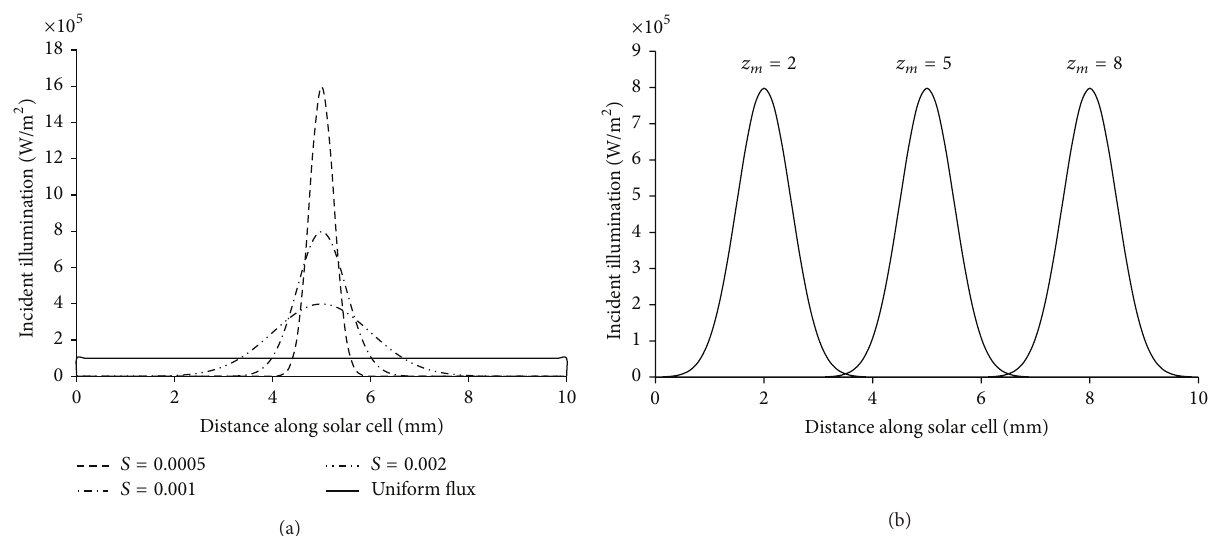
Figure 3: Incident illumination profiles for 𝐶 = 100 at (a) different values of SD and (b) different values of 𝑧 0 .